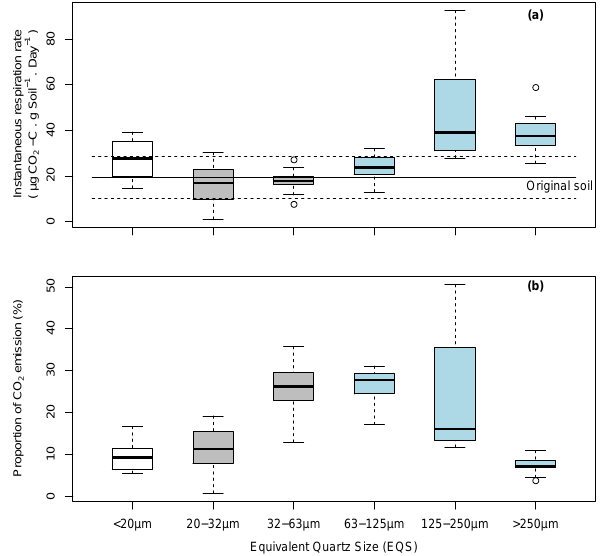
Figure 4. The distribution of instantaneous respiration rate (a) ; and potential CO 2 emission (b) in different Equivalent Quartz Size (EQS) classes of the sediment. The bold and dashed lines in (a) de- note the average and standard deviation of instantaneous respiration rate of the original soil. Colors of the boxes correspond to the likely fate of each fraction after erosion. See Sect. 4.1 and Fig. 6 for def- initions and explanation of the three manners of likely fate. Bars in boxes represent median values. Whiskers indicate the lowest datum within 1.5 interquartile range of the lower quartile, and the highest datum within 1.5 interquartile range of the upper quartile ( n = 18).